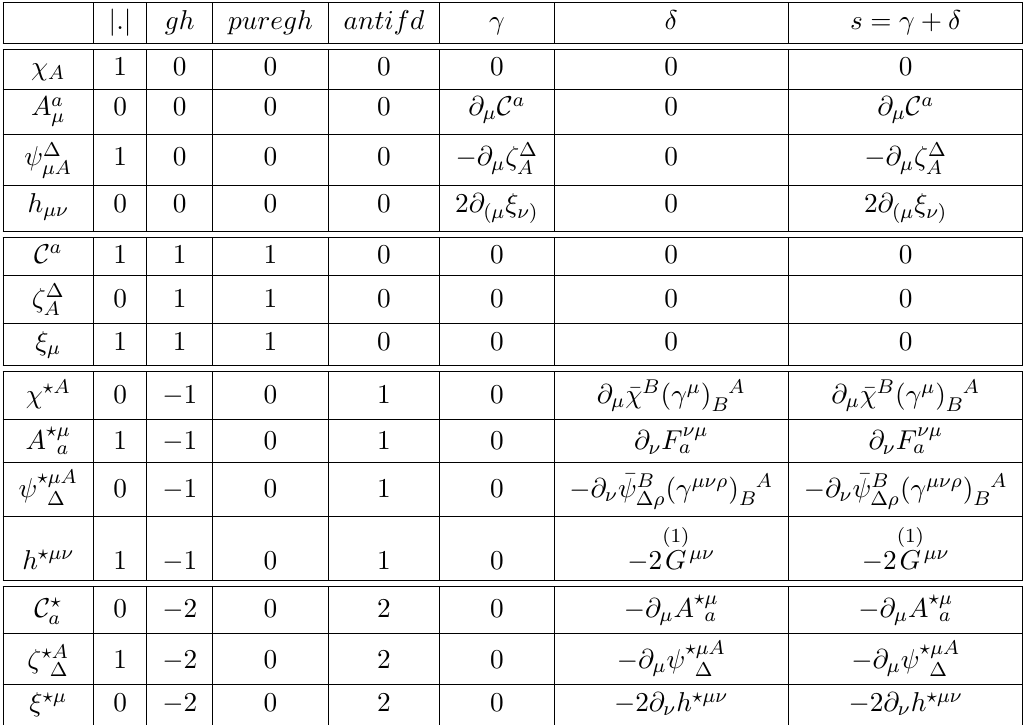
Table 1 . Grassmann parity, ghost number, pureghost number, anti(cid:12)eld number and actions of the di(cid:11)erentials (cid:13) , (cid:14) and s on the various (cid:12)elds of the spectrum, for the theory around (cid:13)at